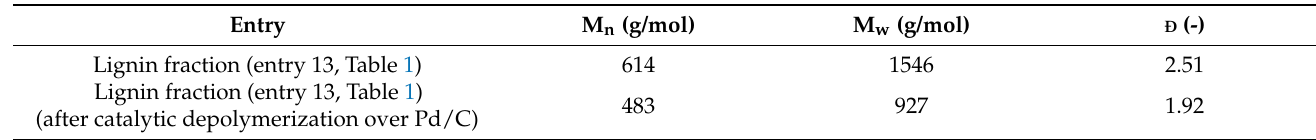
Table 4. GPC analysis of the lignin fraction after delignification (entry 13) and after reductive depolymerization at 180 °C, 2 h, 3 MPa H 2 over Pd/C catalyst. 2 h, 3 MPa H 2 over Pd/C catalyst.